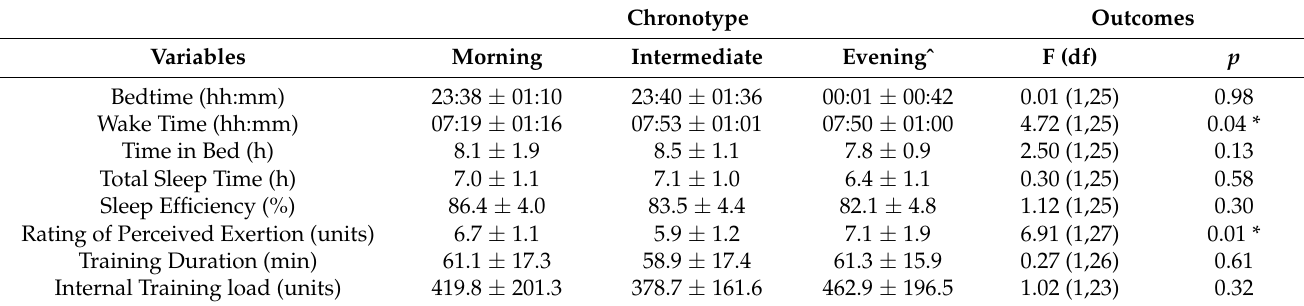
Table 1. Sleep and training variables as a function of